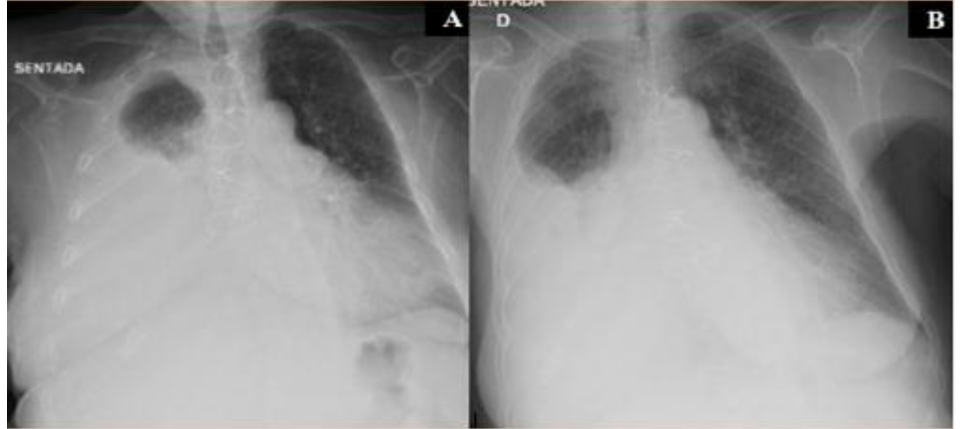
Figure 1. Thoracic X-ray showing increased cardiac index and a large right pleural e ff usion,